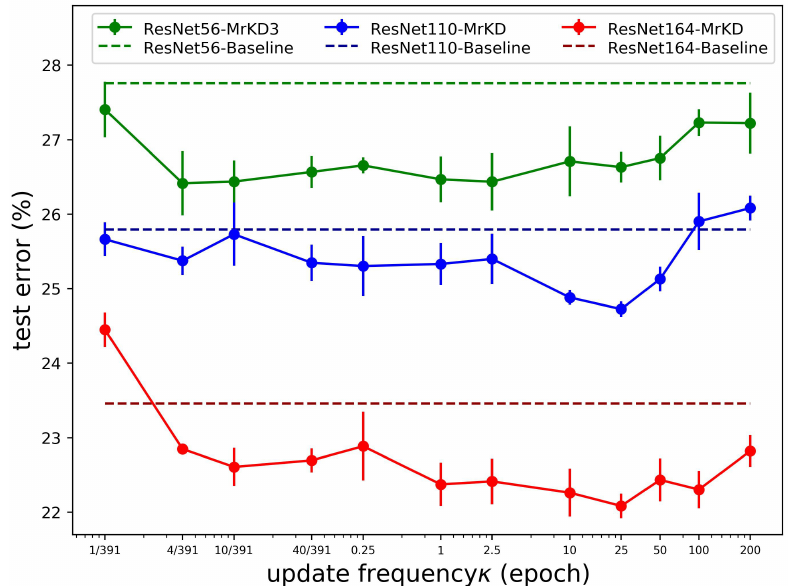
Figure 7. Performance on CIFAR-100 with different update frequency κ .